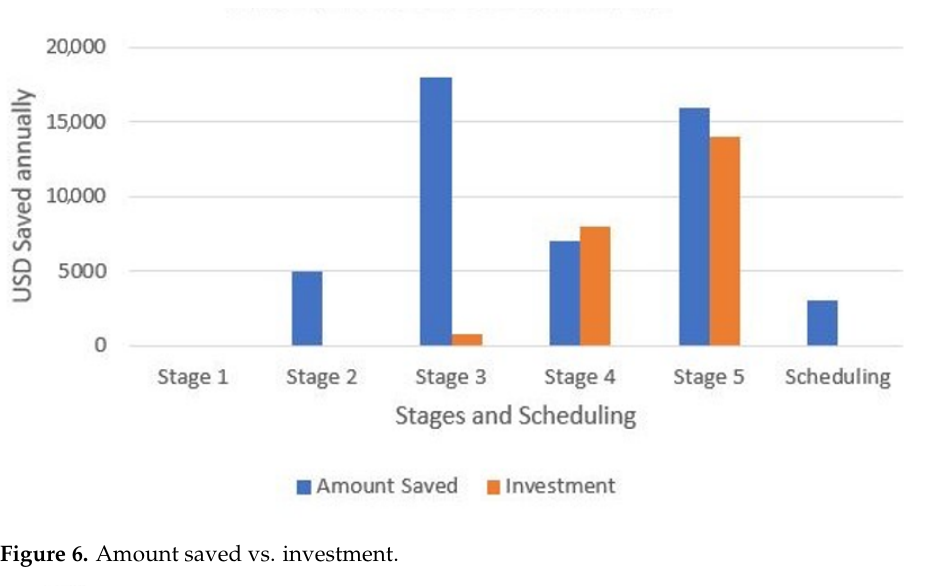
Figure 6. Amount saved vs. investment.